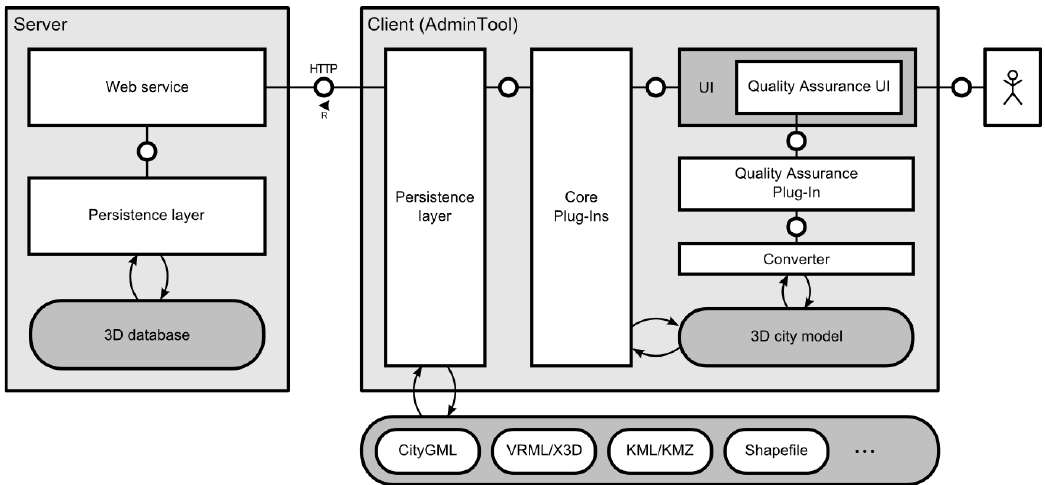
Figure 4: Architectural diagram showing the integration of the quality assurance component into the CityServer3D